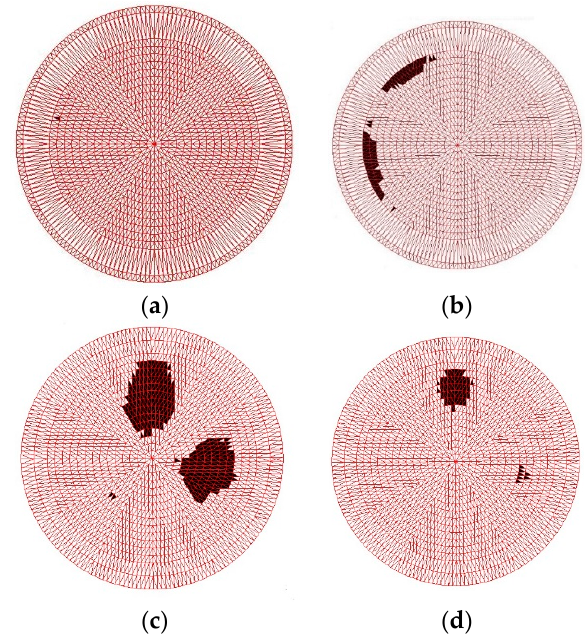
Figure 5. SA-CGA inversion results: ( a ) Single debris (250 µ m). ( b ) Two debris. ( c ) Three debris (2 big and 1 small). ( d ) Three debris (1 big and 2 small).